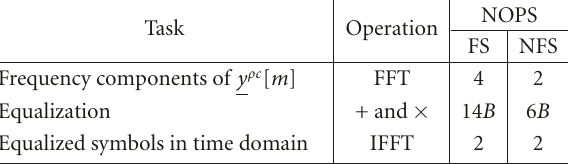
Table 4: Equalization.